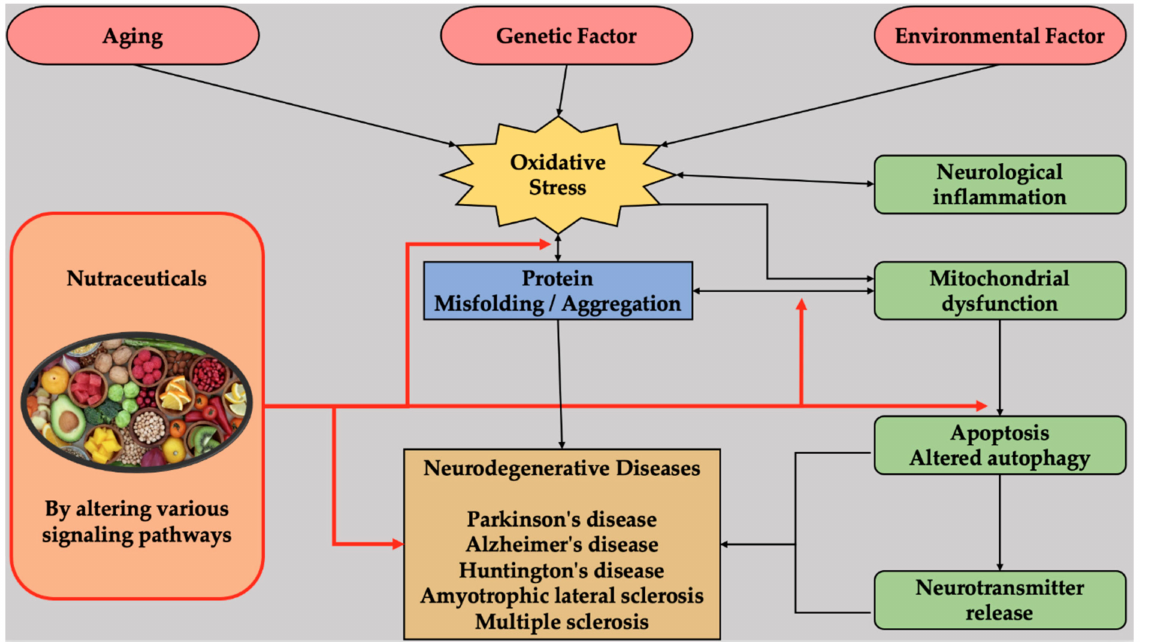
Figure 2. A diagrammatic representation of the cascade involved in NDs and nutraceuticals-mediated multi-targeted